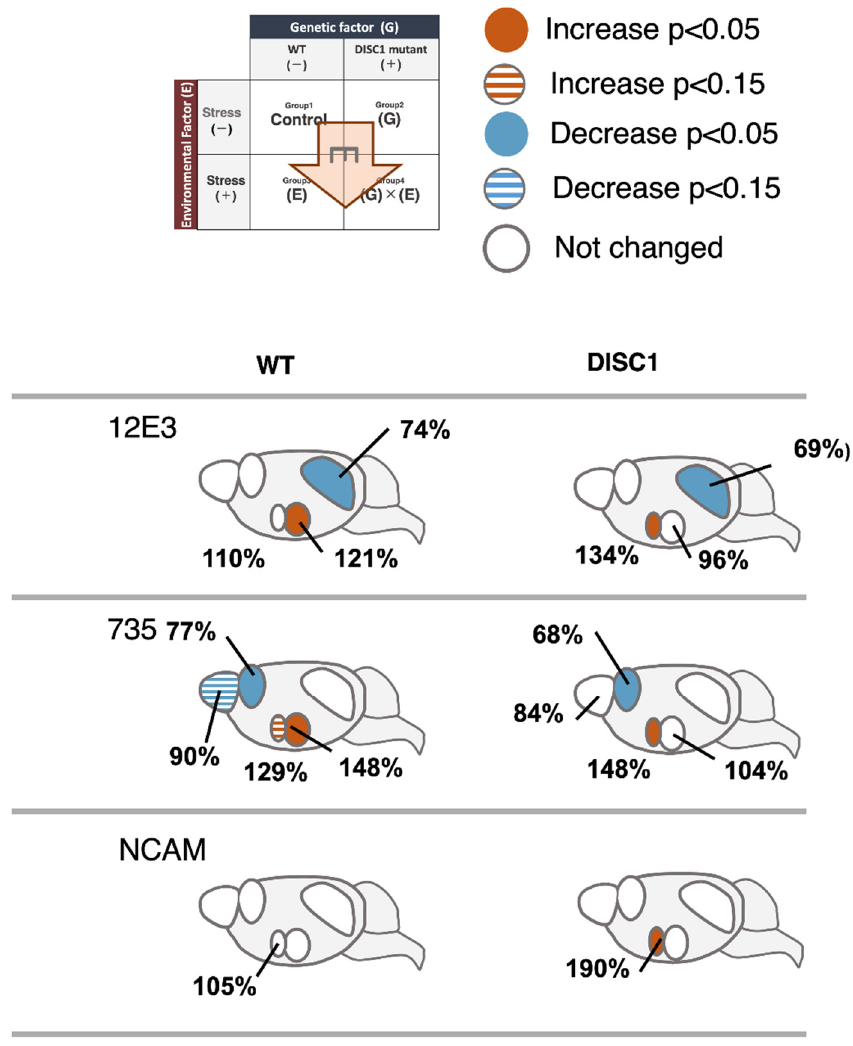
Figure 7. Effect of an environmental factor (acute stress) on the expression of polySia and NCAM. Heat map of changes observed using the 12E3, 735, and NCAM antibodies. [WT, TS − ] (group 1) was set to 100%.